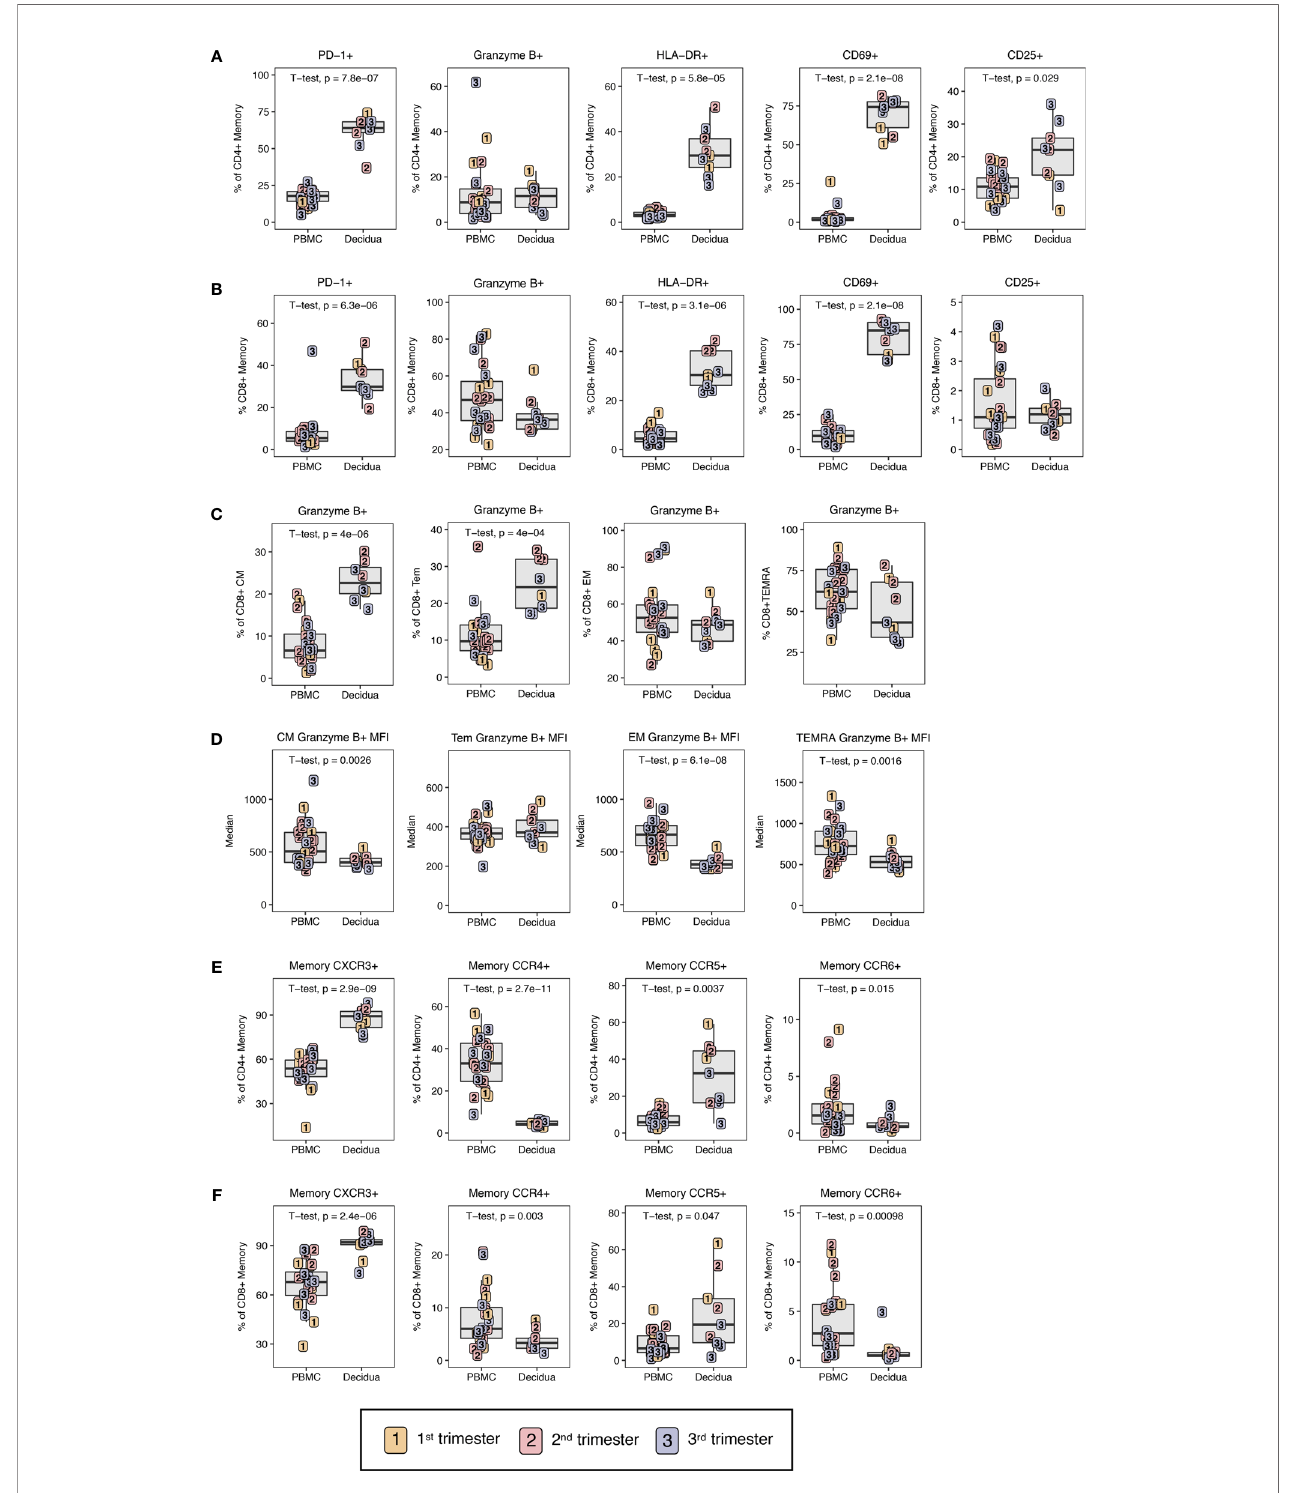
FIGURE 5 | Phenotypic characterization of T lymphocyte memory. (A) Phenotype of CD4+ T cell and (B) CD8+ T cell memory by PD-1, Granzyme B, HLA-DR, CD69, and CD25 in fi rst (yellow), second (red) and third trimester (blue) of pregnancy in PBMC and decidua of normal rhesus macaques. (C) Cytotoxic potential in CD8+ T memory subsets by Granzyme B frequency in CM, Tem, EM, and TEMRA. (D) MFI of Granzyme B in CD8+ T memory subsets. (E) Chemokine receptor expression on memory CD4+ and (F) CD8+ T cells. P-values < 0.05 (unpaired t-test) shown on the